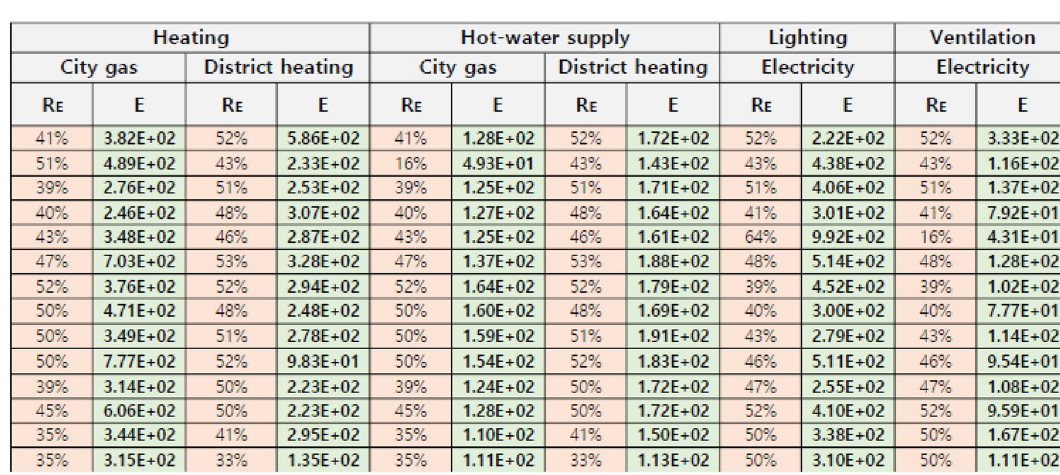
Figure 3. Classified dataset